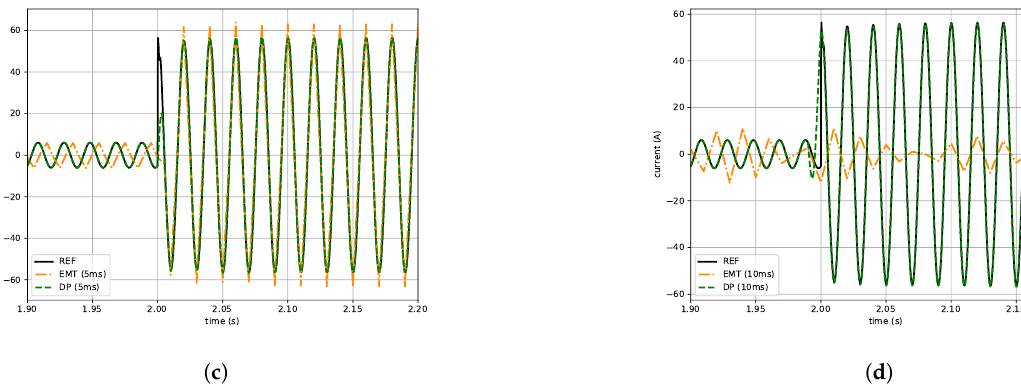
Figure 9. Comparison of EMT and dynamic phasor (DP) simulation results with the averaged inverter model for time steps of 100µs ( a ), 1ms ( b ), 5ms ( c ) and 10ms ( d ).